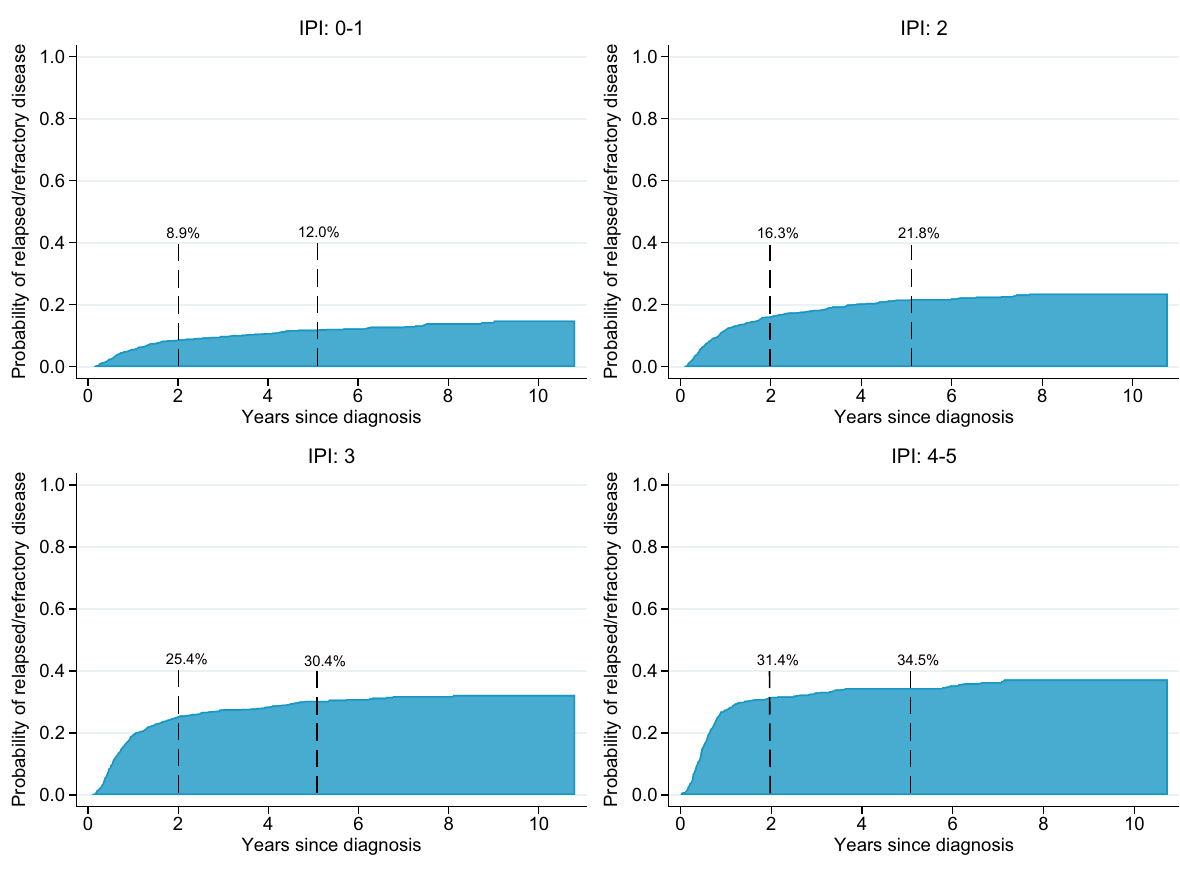
Fig. 3 Incidence of relapsed/refractory disease by IPI. Cumulative incidence of relapsed/refractory disease at any site among curatively treated diffuse large B-cell lymphoma (DLBCL) patients by IPI (0 – 1, 2, 3, 4 – 5) (incidence assessed in the presence of the competing risk of death*). Asterisk indicates not